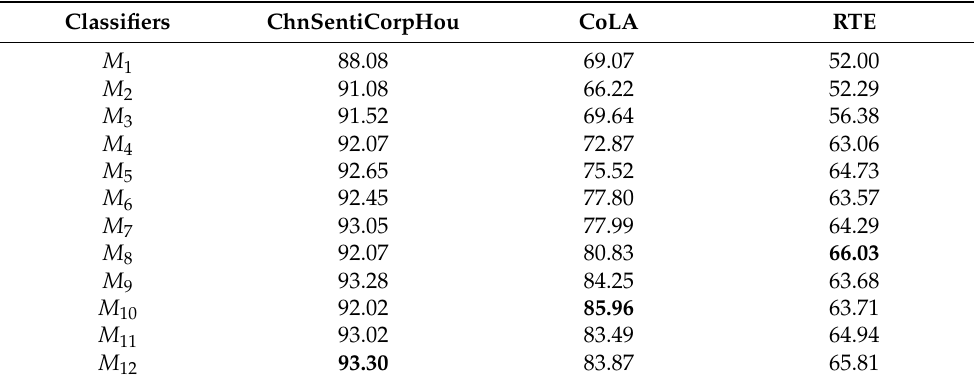
Table 1. Test accuracy (%) of M 1 , . . . , M 12 on three BTC datasets. Each row corresponds to a classifier with a truncated BERT with a different number of Transformers as its encoder. Column 2–4 are the classification accuracies these classifiers achieve on the three datasets. Bold denotes the highest